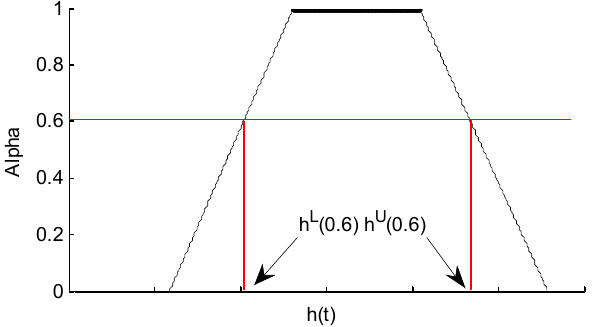
Fig. 4. membership function and  cut (